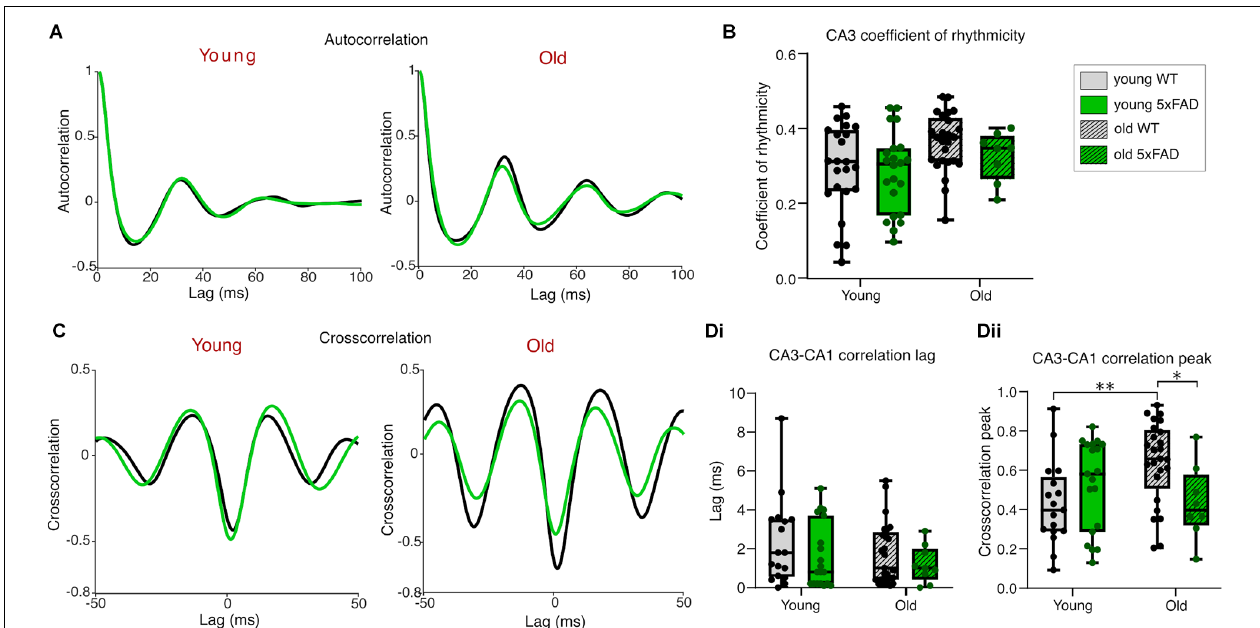
FIGURE 3 | Rhythmicity of carbachol-induced gamma oscillations. (A) Mean autocorrelograms from CA3 recorded gamma oscillations. (B) Boxplots of the calculated coefficient of rhythmicity of the oscillations (see Section “Materials and Methods” for details of calculation). (C) Mean cross correlograms of CA3-CA1. (D) Group data cross correlation lags (Di) and peaks (Dii) from CA3 to CA1. Young WT: n = 23/17 (A,B/C,D) , eight mice (three females); Young 5xFAD : n = 23/19 (A,B/C,D) , eight mice (four females); Old WT: n = 25/25 (A,B/C,D) , six mice (one female); Old 5xFAD : n = 8/9 (A,B/C,D) , five mice (two females). ∗ p < 0.05, ∗∗ p < 0.01 (two-way ANOVA with Sˇ idák correction for multiple